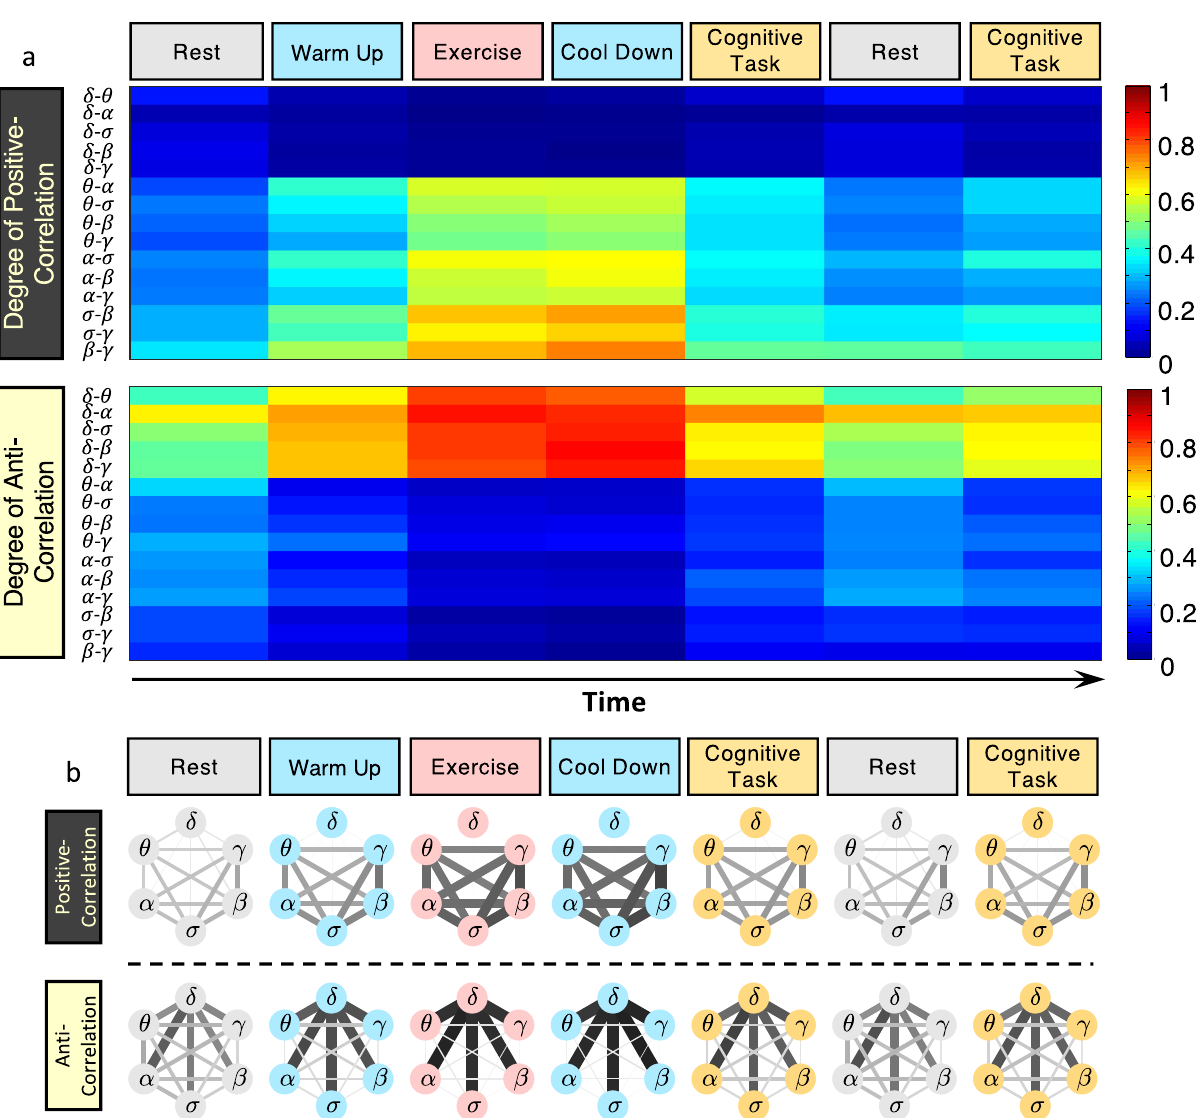
Fig. 4 Network of cortical rhythm interactions and their evolution across physiological states. a Color-coded matrix representation of the degree of positive and anti-correlated coupling for all pairs of cortical rhythms shows the evolution of interactions in response to different physiological states. Increasingly synchronous modulation in the micro-architecture of bursting activity in θ , α , σ , β and γ rhythms leads to a high degree of positive coupling between these rhythms that is most pronounced during exercise (top panel, red color). This behavior is paralleled by asynchronous modulation in bursting dynamics in δ waves compared to other cortical rhythms leading to anti-correlated coupling most pronounced during exercise (red color), intermediate during the cognitive task (orange), and weak during rest. Note the consistency in coupling patterns (columns) for repeated segments of rest and the cognitive task where subjects are in quasi-stationary states. The difference between transient periods of warm-up and cool-down indicates a robust association of cortical rhythms coupling forms and strength with distinct physiological states. b Networks of brain-wave interactions for different physiological states, where network nodes represent cortical rhythms at the C3 EEG channel location, and links indicate the degree of coupling (line thickness and darkness correspond linearly to link strength). Coexisting sub-networks of positive (top panel) and anti-correlated (bottom panel) interactions among cortical rhythms with the speci fi c topology of links strength uniquely de fi ne each physiological state. A pronounced network cluster of strong anti-correlated interactions of δ wave with all other brain rhythms is paralleled by a complementary cluster of positively coupled rhythms during exercise. With transitions to warm-up, cool-down, cognitive task and rest, these parallel networks of coordinated interactions evolve and are characterized by different topology and organization of links strength. Both positively and anti-correlated sub-networks of brain-rhythm interactions show transients where link strength can vary for different time segments within a given physiological state, re fl ecting complex dynamics of on/off brain-wave cross- communications are essential to facilitate fl exibility and maintain the state. The coexistence of positive and anti-correlated interactions with different strengths among brain rhythms uniquely de fi nes physiologic states. The speci fi c topology and clustering of these networks for distinct physiological states demonstrate a direct association of the network cross-communication among brain rhythms with physiological states and particular, during rest θ - β interaction is characterized by a synchronously increase or decrease in strength (Fig. 4b). Such positive cross-correlation coupling component in the D + matrix, reorganization with transitions across states is observed globally at the network level as well as at each node, indicating a complex the strength of which gradually increases during cognitive task hierarchical cross-communication among brain rhythms. In and warm-up, and is highly expressed during exercise and cool-